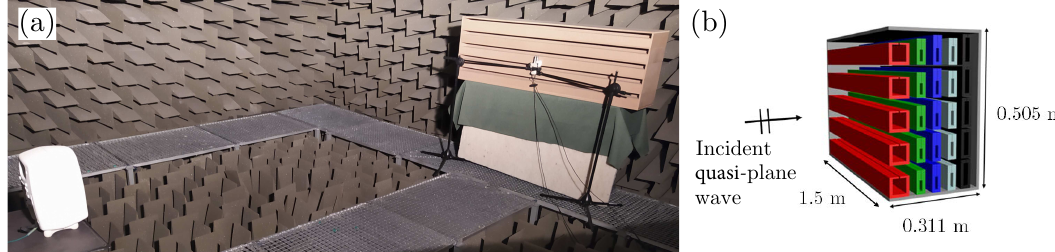
Figure 4. Experimental setup of the 2D finite array of Helmholtz resonators inside the anechoic chamber. ( a ) Picture of the experimental configuration. ( b ) Schematic diagram of the 2D system of Helmholtz